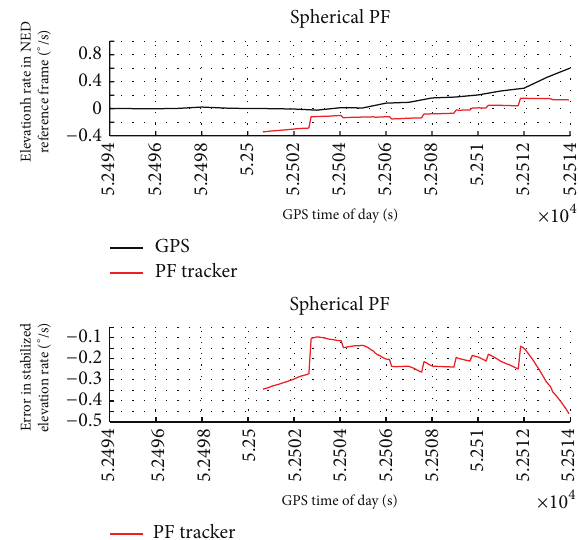
Figure 10: Elevation rate in NED reference frame as estimated by GPS and by radar-only tracker and estimation error as a function of GPS time of day.